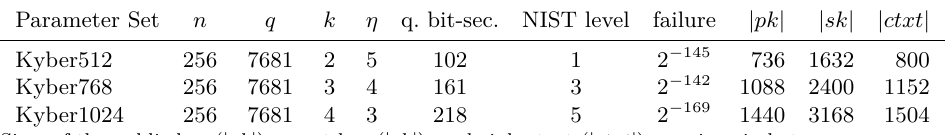
Table 1: Parameters proposed to NIST for instantiating Kyber KEM.